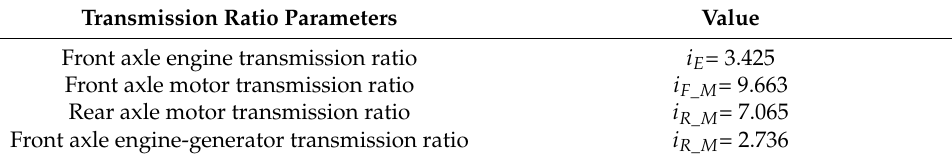
Table 2. Driveline ratio information.